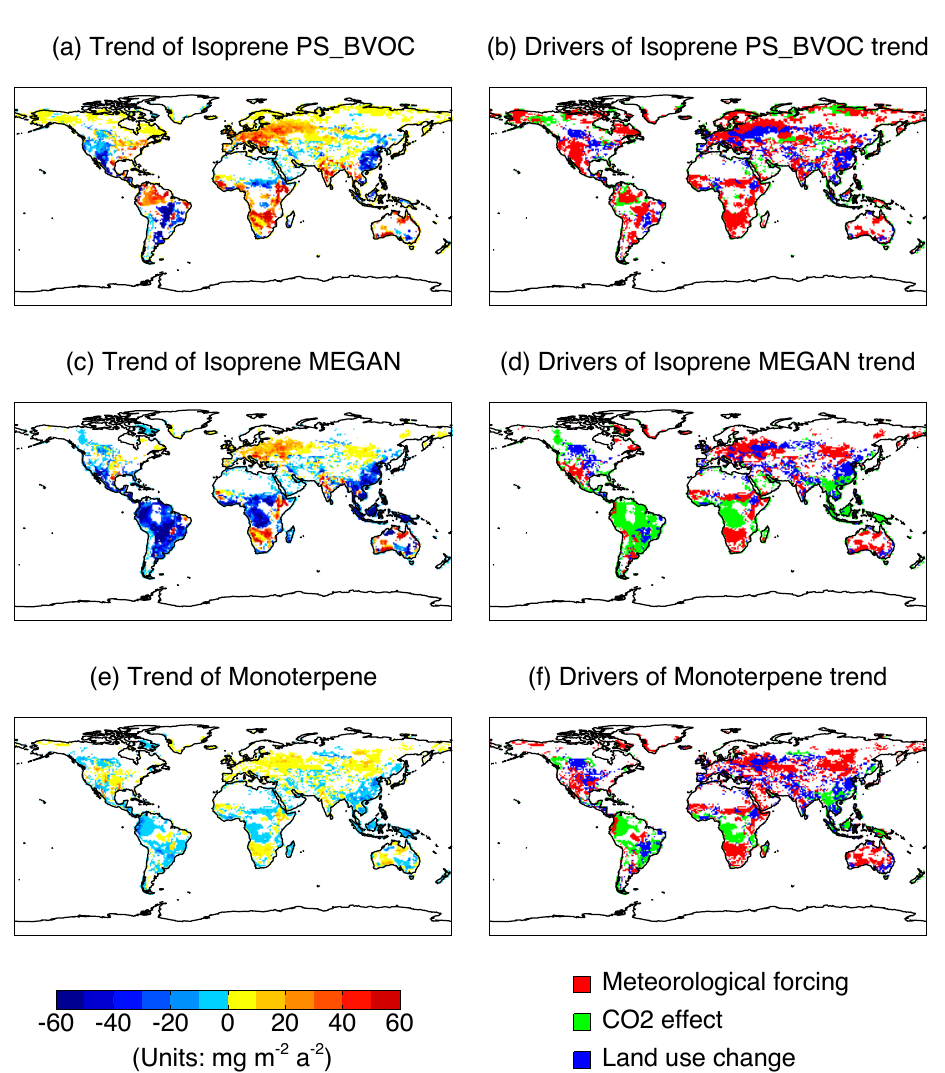
Figure 6. Simulated trends of (a, c) isoprene and (e) monoterpene and (b, d, f) the dominant drivers for these changes during 1982–2011. Simulations are performed with WFDEI reanalysis. Isoprene emissions are simulated with (a) PS_BVOC and (c) MEGAN schemes. Three factors, meteorological forcing, CO 2 effects (both fertilization and inhibition), and land use change, are considered as the potential drivers of flux trends. For each grid in figures (b, d, f) , the factor generating the largest (either maximum or minimum) trend with the same sign as the net change (a–c) is selected as the driving factor. Only significant trends ( p < 0 . 05) are